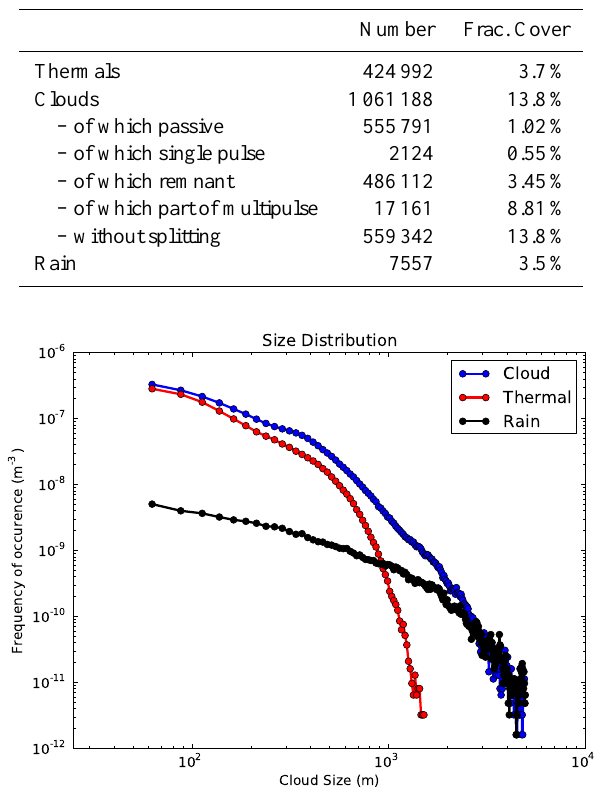
Table 1. Number and average fractional cover of thermals, clouds and rain patches in 40h of RICO simulations.